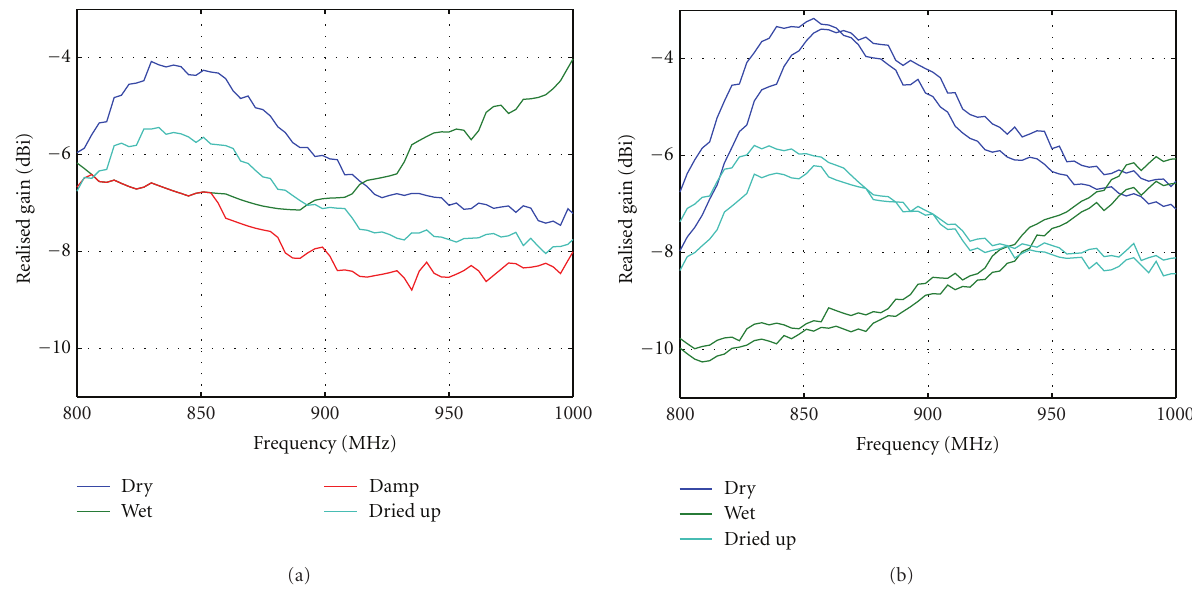
Figure 8: (a) PVA1 glue coated tag; (b) PVA2 coated tag (two samples); all on Fabric (A). Even though the PVA1 glue dissolves in water, the tag coated with this wet glue performs well. After drying up, the glue and the PVA1 coated tag operate like before washing, with a 1.5 dB decrease in realised gain. The gain of the PVA2 coated tag decreases by 3 dB.